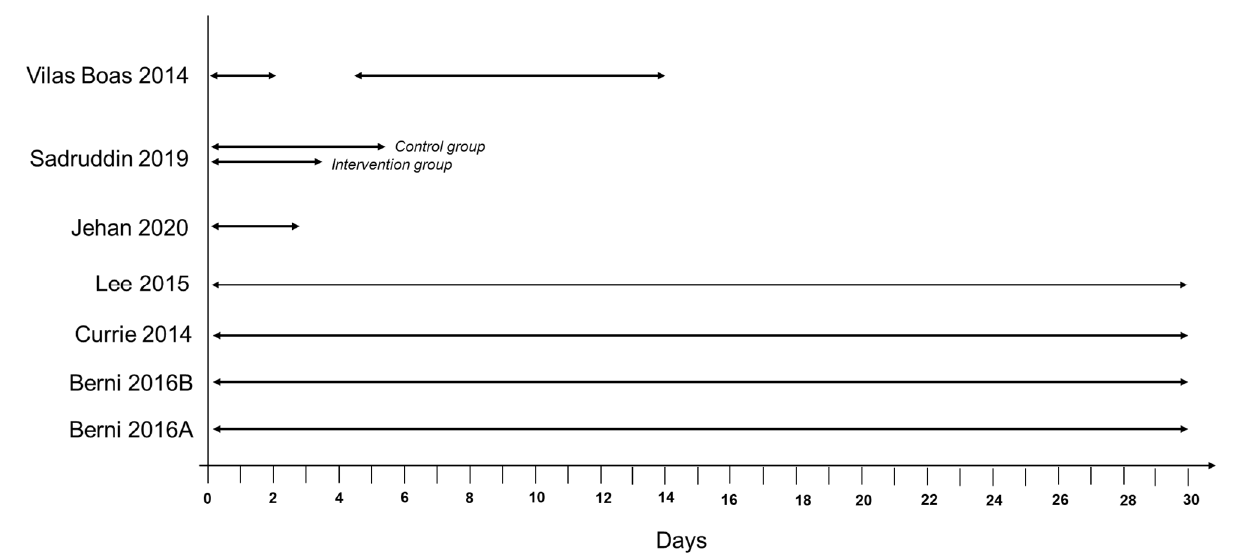
Figure 2. Time in days for ascertaining death in RTI studies.